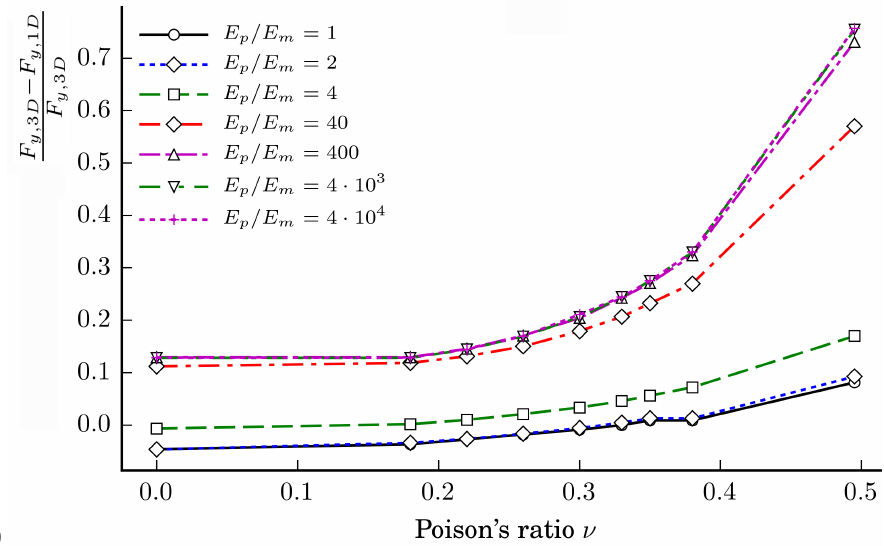
Figure 11. Dependences of the relative ratios ( F y ,3 D − F y ,1 D ) / F y ,3 D of the axial forces of the loading case LC1 on the Poisson ratio ν p = ν m at different ratios E p / E m when particles’ diameter d p = 13